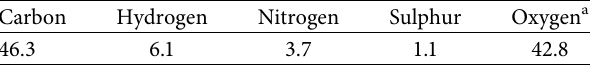
Table 4: Ultimate analysis (ash free basis) in wt%.